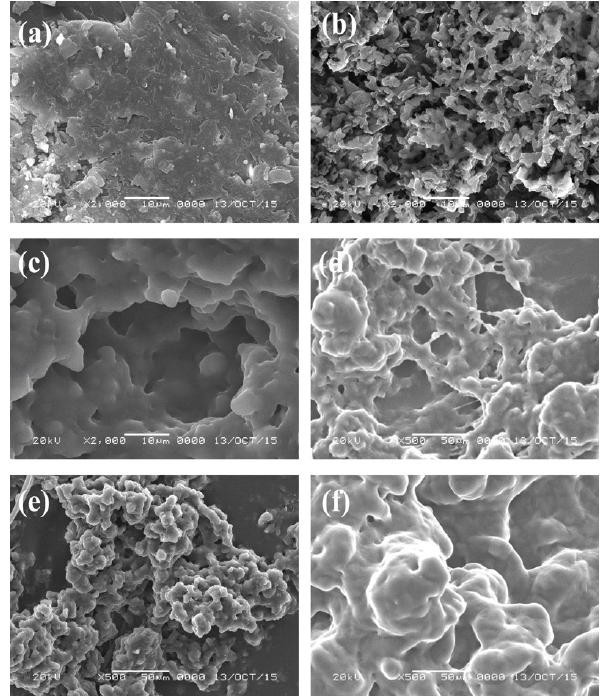
Figure 3. SEM images of ( a ) nonporous PNIPA gel; ( b ) porous PNIPA gel; ( c ) porous PeDEGA gel; ( d ) porous PDEGA gel; ( e ) porous PTEGA gel; and ( f ) porous POEGA 480 gel (scale bar length: 10 µm).